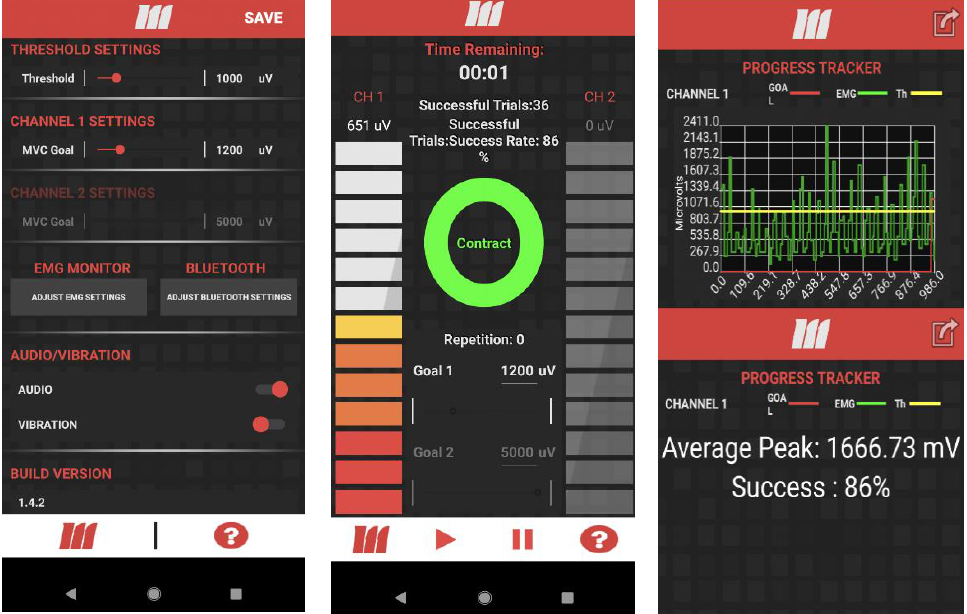
Figure 3. ( Left ) The setting panel for the mTrigger phone app. The threshold and goal are set on this screen. Additionally, audio, and haptic (‘vibration’) feedback can be turned on or turned off. ( Middle ) This panel is displayed during training. Near the top, time remaining as well as the number of successful trials and overall success rate is shown for the trial. The red to gray bar graph on the left side indicates progress towards a force goal for Channel 1. ( Top Right ) This shows the tracking panel. This panel is used to display the session data. The square button with the arrow is used to upload the data to Google Cloud. ( Bottom Right ) This is displayed when clicking on the tracked data ( Top right ), which shows the average peak muscle activity for the duration of trial and the success rate. This average number can be used in an initial trial to detect and set the initial threshold and subsequent activation goals. Success rate can be used as an outcome measure and additionally to make sure participants meet the increased goal at a minimum rate.